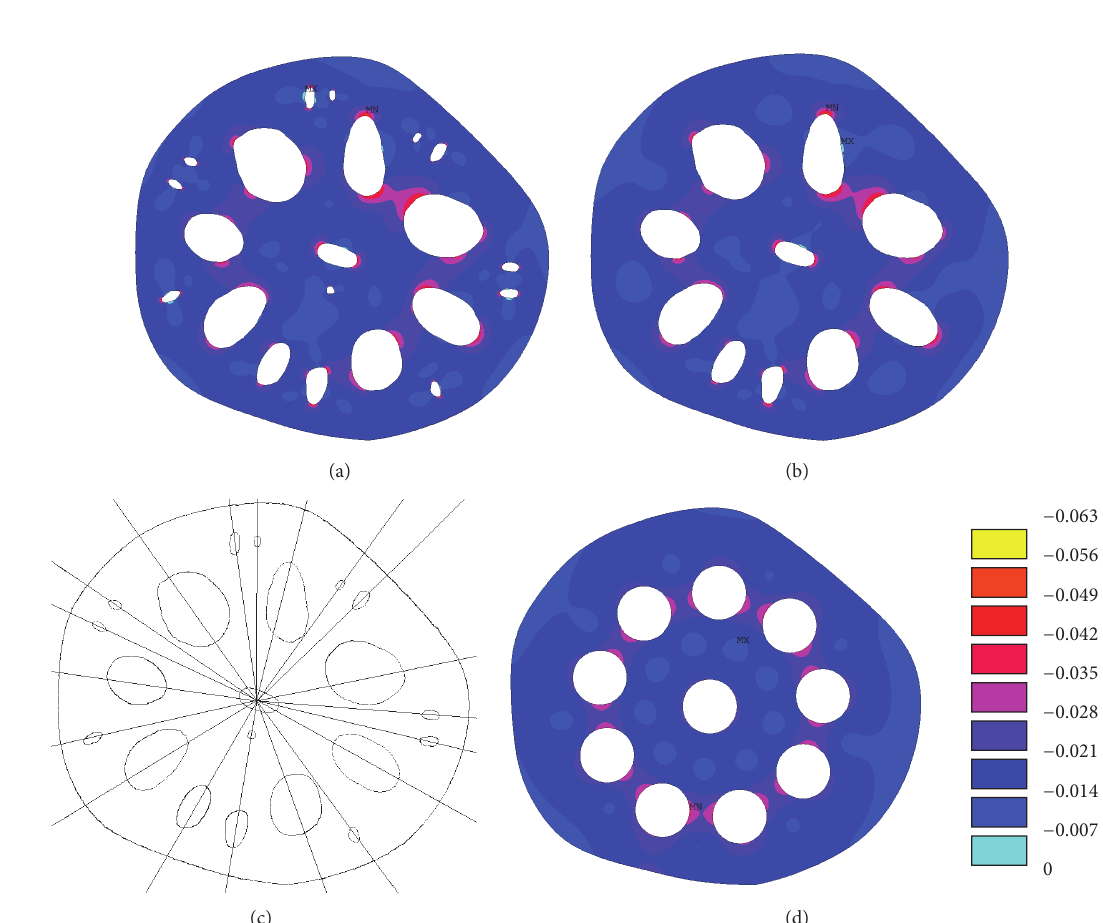
Figure 5: Compressive stress (MPa) in the lotus root (a) with small holes, (b) no small holes, (c) radial lines through oval holes, and (d) compressive stress in the cross-sectional area with circular